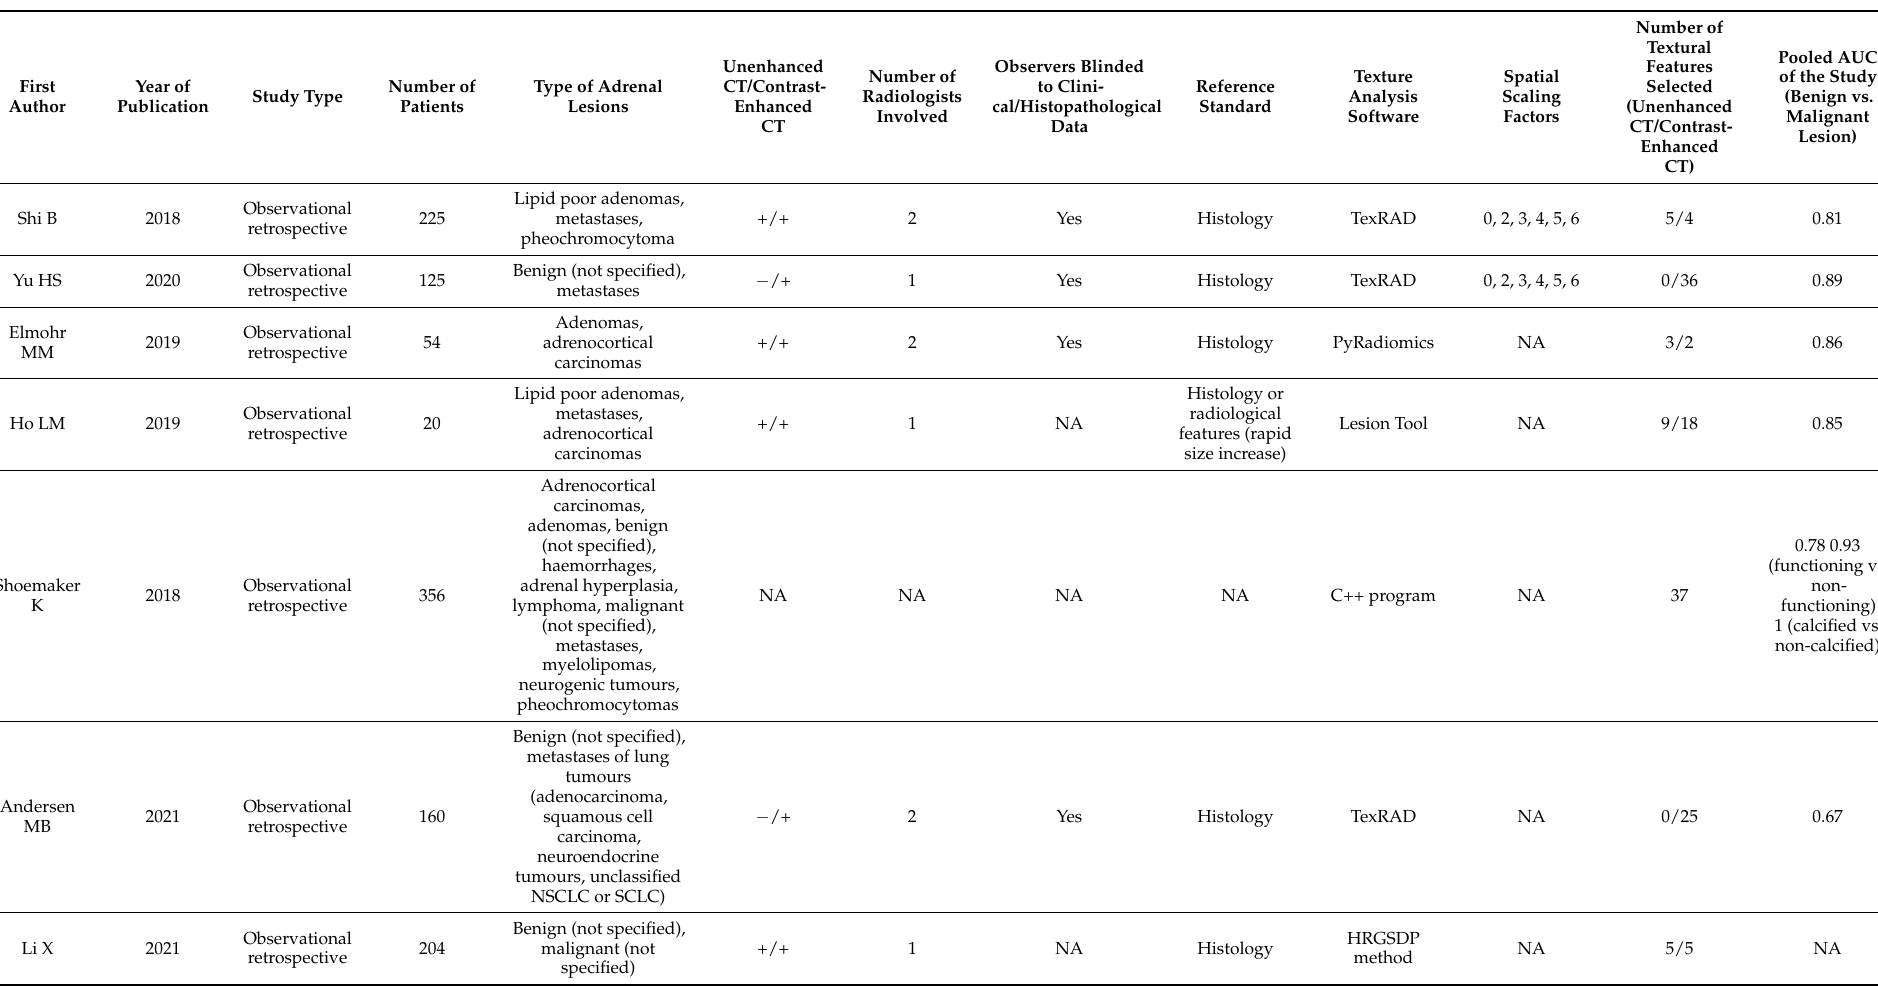
Table 1. Characteristics of the papers selected for the systematic